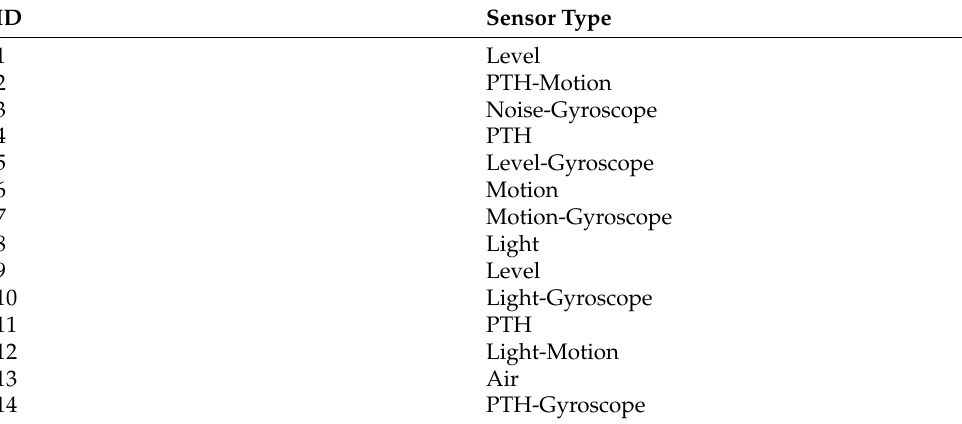
Table 3. Connected sensor types in each zone of house. Each type of sensor measures a parameter of environment.